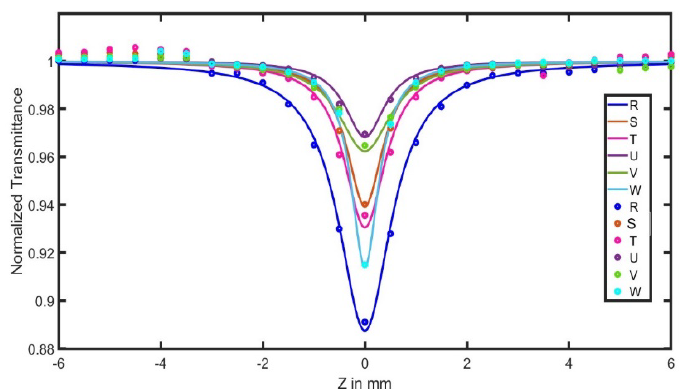
Figure 8. Open ‐ aperture Z ‐ scan curves for the samples: R (Ag), W (Al 2 O 3 ), V (Al 2 O 3 /PVA film), S (Ag/PVA film), T (Ag/Al 2 O 3 /PVA1 film), U (Ag/Al 2 O 3 /PVA2 film). (Ag/PVA film), T (Ag/Al 2 O 3 /PVA1 film), U (Ag/Al 2 O 3 /PVA2 film).